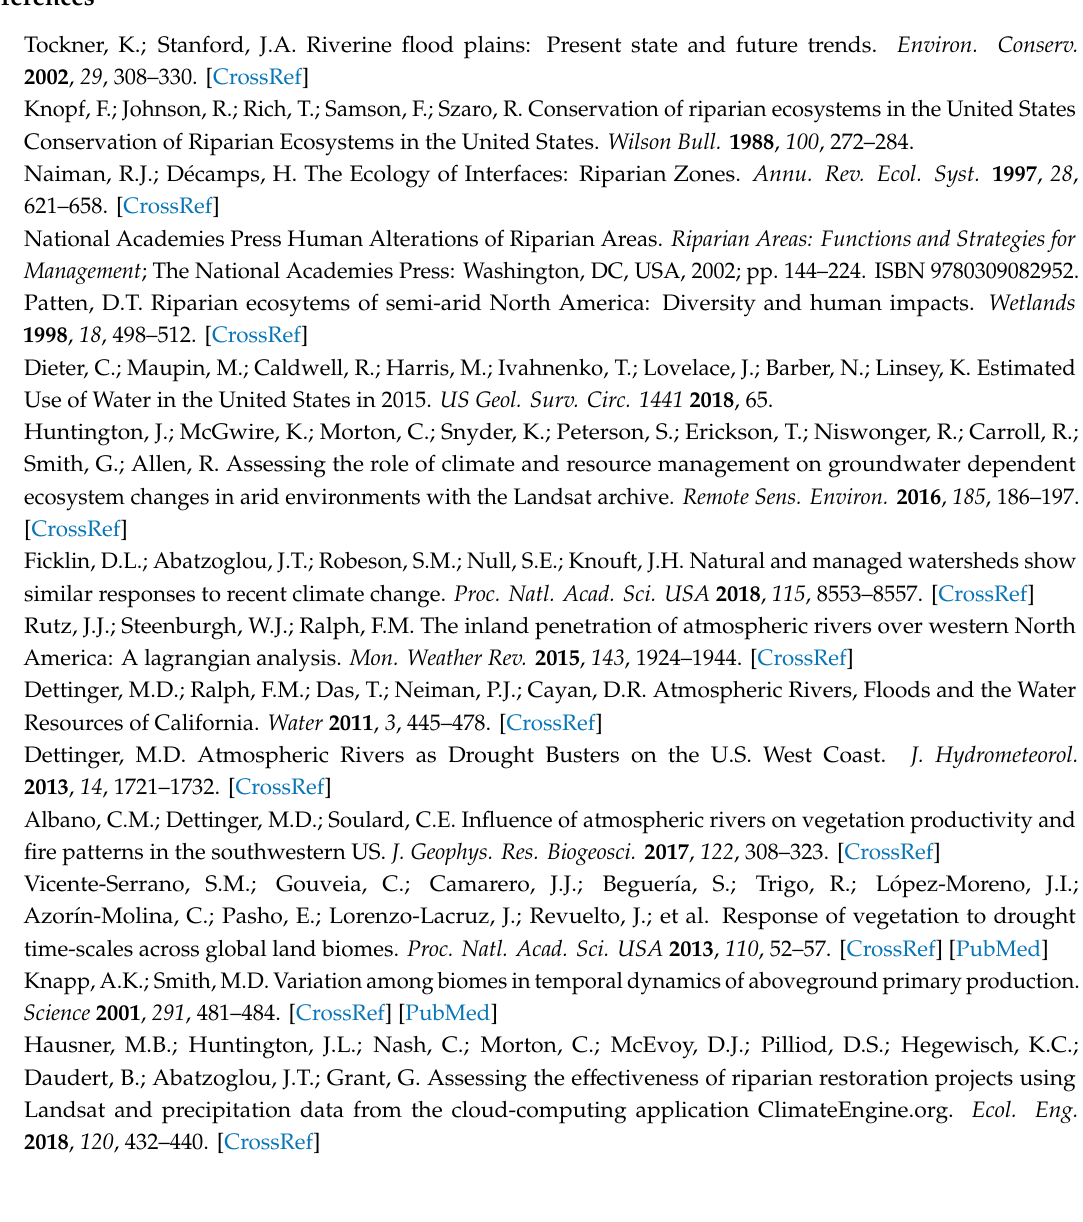
Figure S1:Comparison of coefficients of determination (R 2 ) for NDVI relations to Standardized Precipitation–Evapotranspiration Index (SPEI), Standardized Precipitation, and Standardized Evapotranspiration by EPA Level 4 Ecoregion, Figure S2: Timing of peak NDVI in upland (left) and riparian (right) vegetation by EPA Level 4